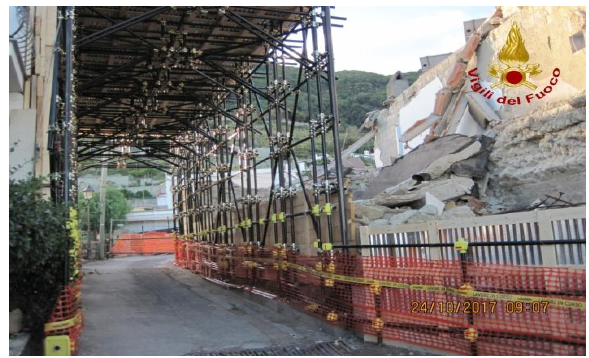
Figure 17. Tunnel with joint pipes